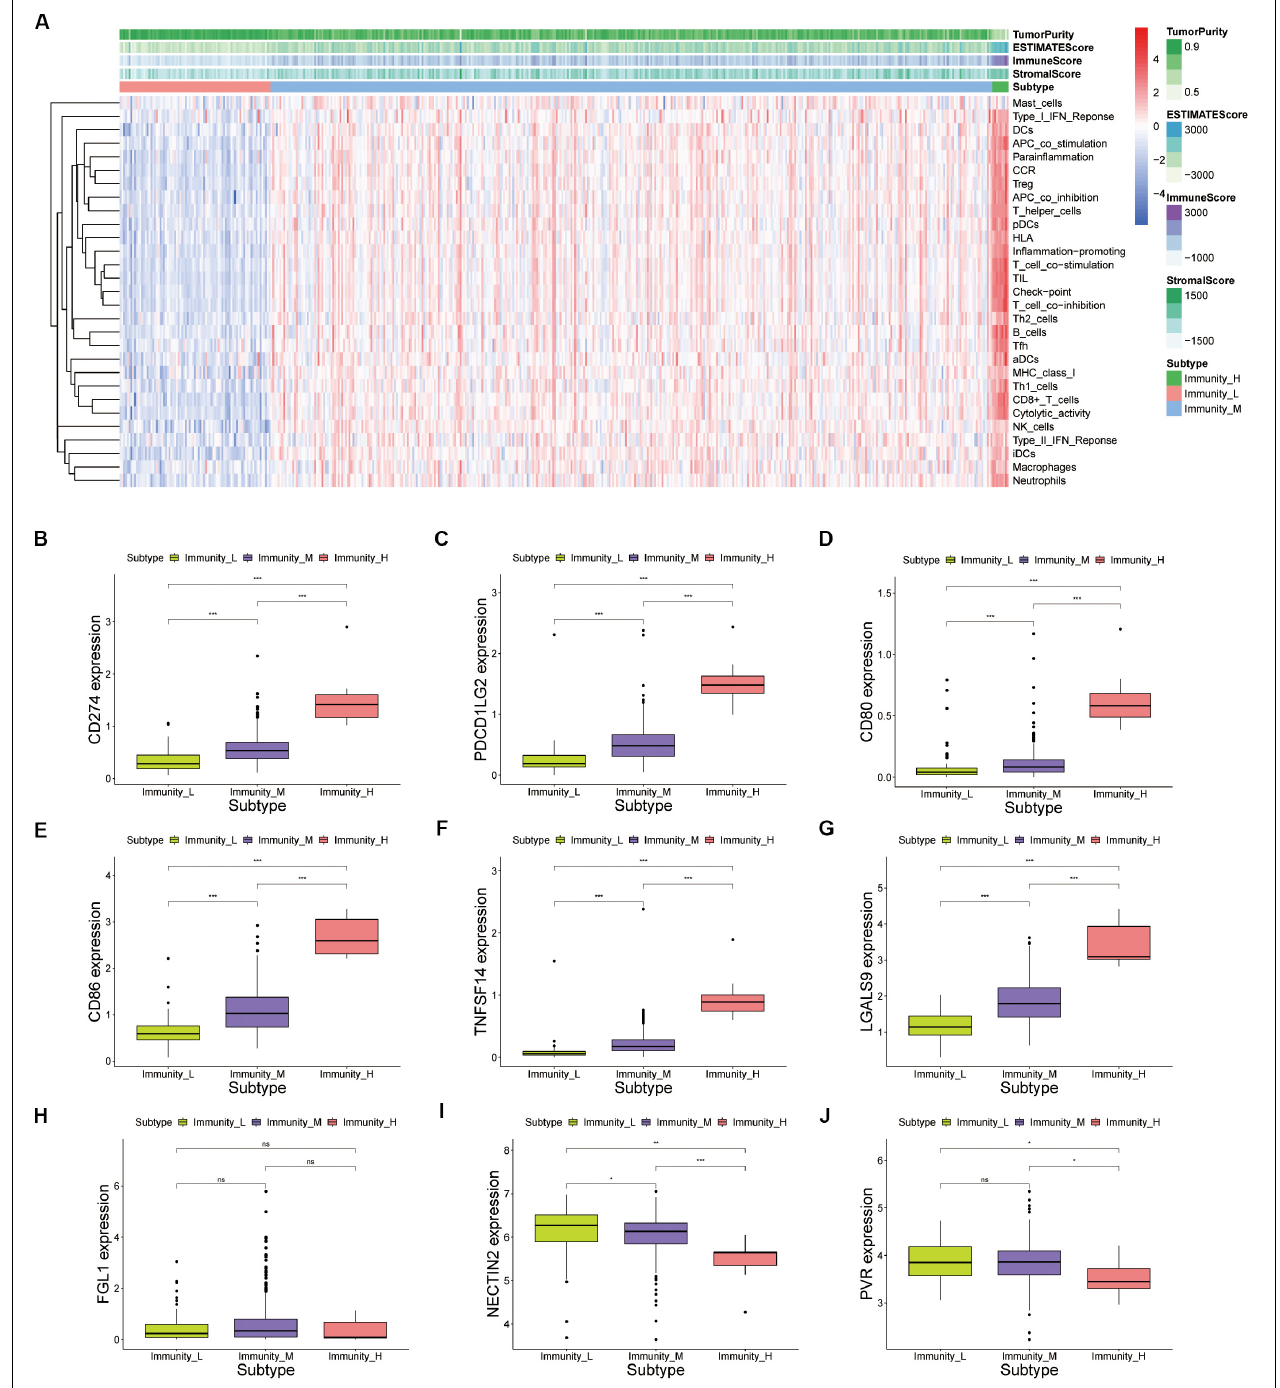
FIGURE 3 | (A) Unsupervised clustering of PRAD patients using ssGSEA scores from immune cell types. The tumor purity, estimate score, immune score, and stromal score were shown as patient annotations in the top panel. (B–J) Inhibitory ligands of CD8 + T cells expressed by tumor cells were expressed in the high, medium and low immune groups of prostate cancer ( p value, * < 0.05, ** < 0.01, *** < 0.001).